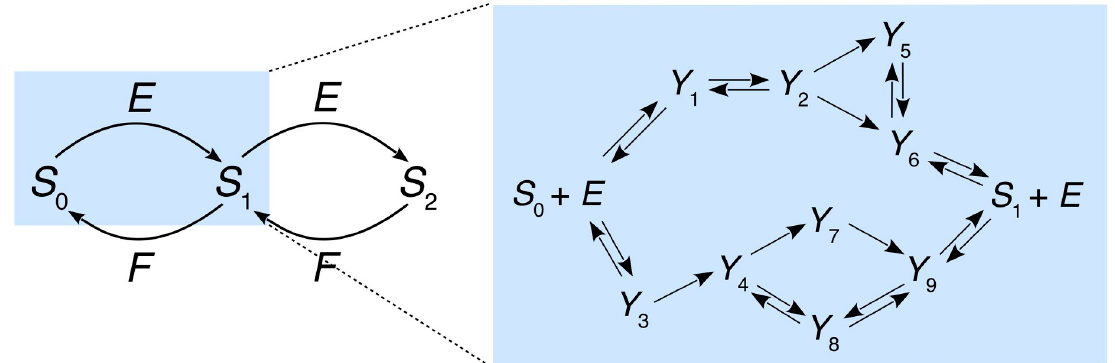
Fig 2. Reaction network and example enzyme mechanism for a two-site PTM system. A two-site PTM system is shown, in which modification and demodification are sequential and in which each enzymatic step yields a single product (“distributivity”). The box on the right shows an example of an enzyme mechanism made up from the elementary reactions in the grammar in Eq 1, illustrating multiple routes and multiple intermediate enzyme-substrate complexes. This example is weakly irreversible: the product S 1 can bind to E but cannot be converted back into substrate S 0 , so that the mechanism is irreversible